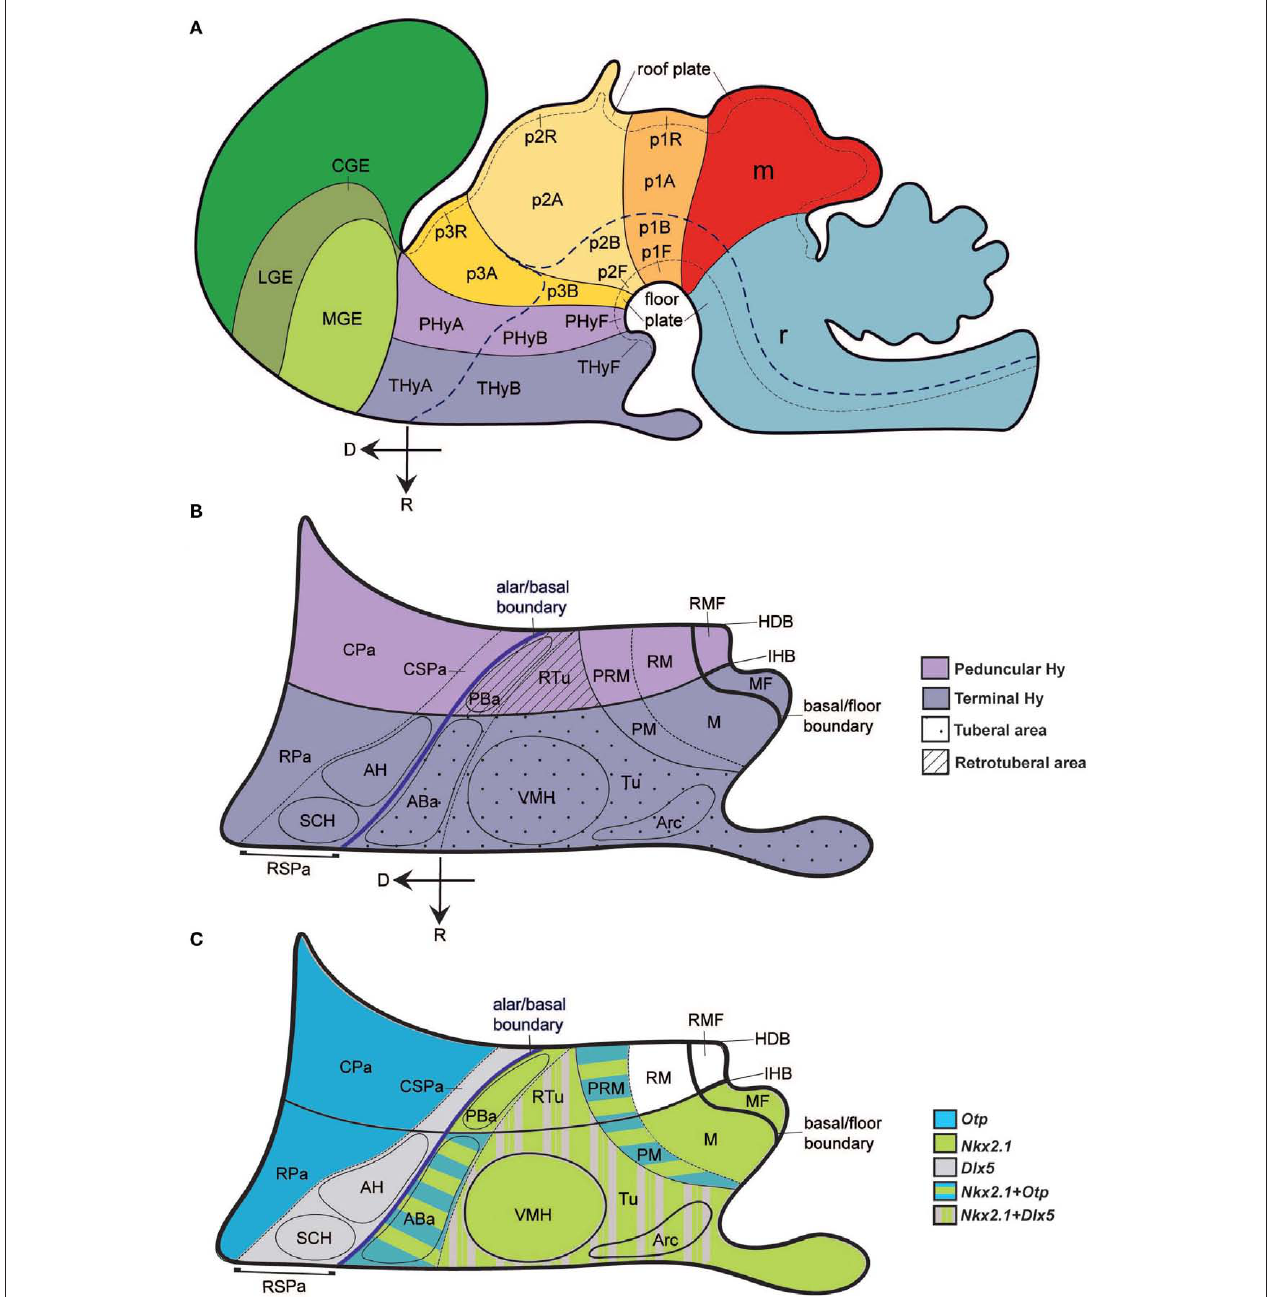
(RPa, CPa) from the rostral and caudal subparaventricular subdomains (RSPa, CSPa). The RSPa contains the suprachiasmatic and anterior hypothalamic nuclei (SCH, AH). Within the basal plate, a thin continuous black line separates the tuberal and retrotuberal regions (Tu/RTu; dotted and striped fills, respectively) from the mamillary complex (undotted). A dashed line separates the dorsal Tu/RTu subregion, occupied by the anterobasal and posterobasal nuclei (ABa, PBa) from the main tuberal/ retrotuberal region, which contains the VMH, Arc, and DMH nuclei. Another dashed line divides the mamillary body into the dorsal perimamillary/periretromamillary regions (PM, PRM) and the ventral mamillary and retromamillary areas (M, RM). The corresponding parts of the hypothalamic floor lie underneath (MF, RMF). (C) Schematic reference gene expression patterns used in our mapping, represented upon the same diagram shown in (B) . Striped color patterns imply